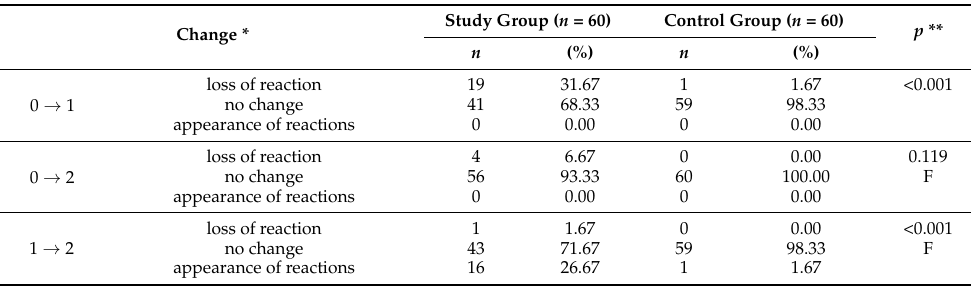
Table 7. Comparison of the change in the threshold of excitability of the pulp of second molars in the test and control groups between individual time points as measured by a pulpometer.